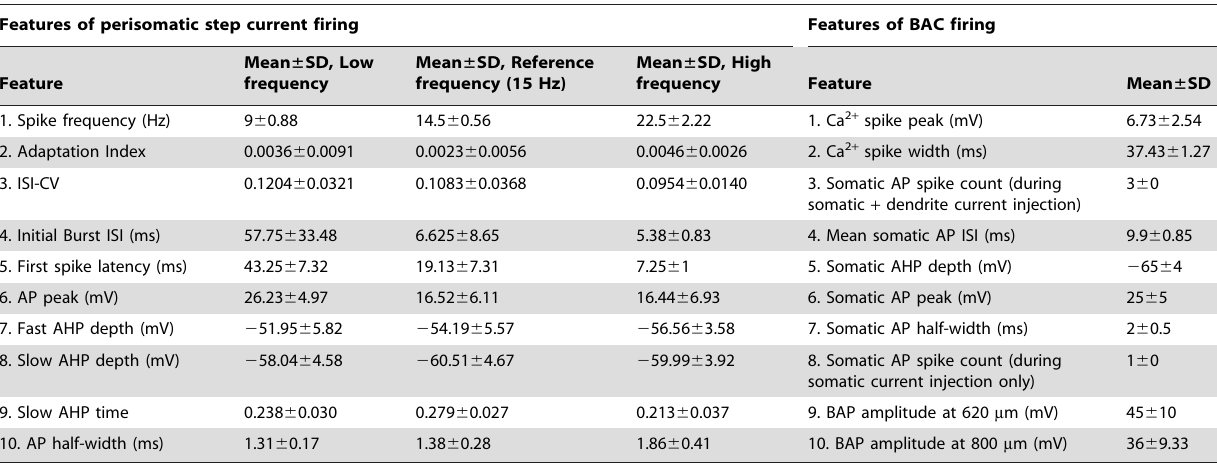
Table 1. Mean and SD values of features of perisomatic step current firing and of BAC firing.